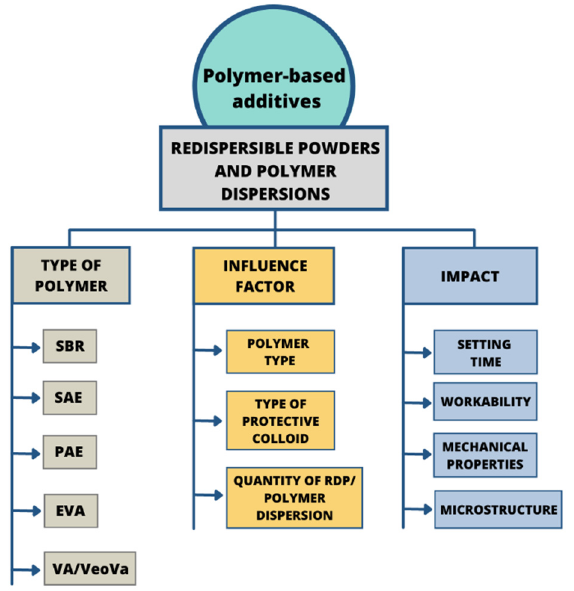
Figure 5. Schematic representation of redispersible powders and polymer dispersion type, influence factors and changes caused in concrete-based composites.